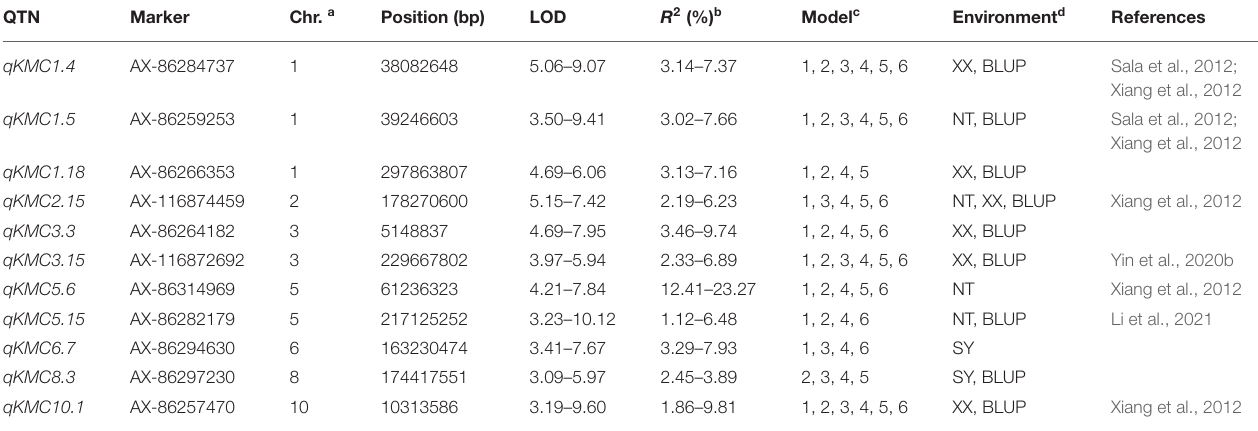
TABLE 2 | Stable QTNs for KMC co-detected by at least four models under a uniform environment or in at least two environments and BLUP using the same ML-GWAS model. QTN Marker Chr. a Position (bp) LOD R 2 (%)